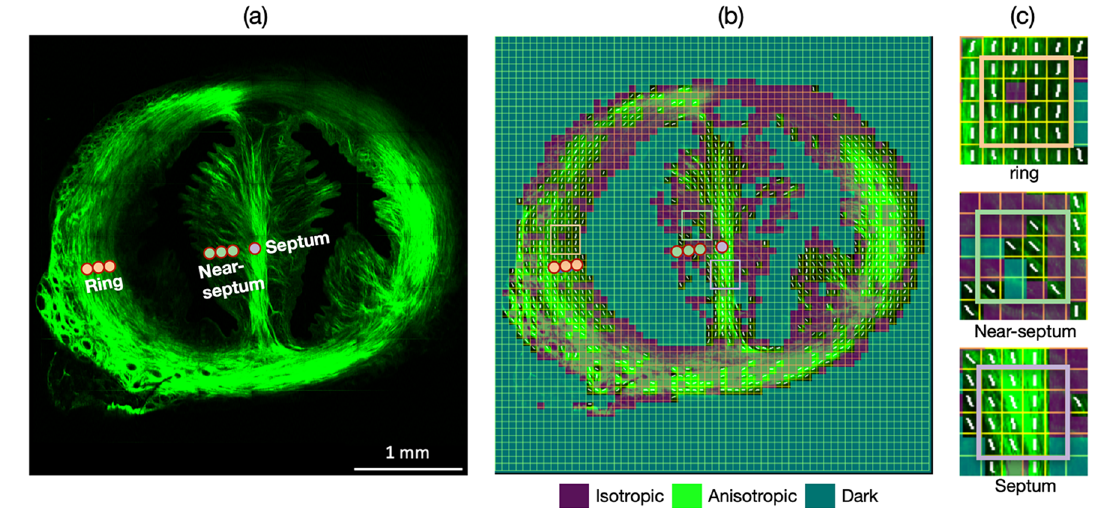
Figure 1. 2D FT-SHG analysis of rat cervix tissue. ( a ) 2D SHG image of the rat cervix and ( b ) distribution of isotropic, dark, and anisotropic areas over the SHG image. ( c ) Enlarged images of the ring, near-septum and septum. Colored circles show representative areas that were subsequently captured in 3D. The white lines ( b , c ) show the orientation of the anisotropic